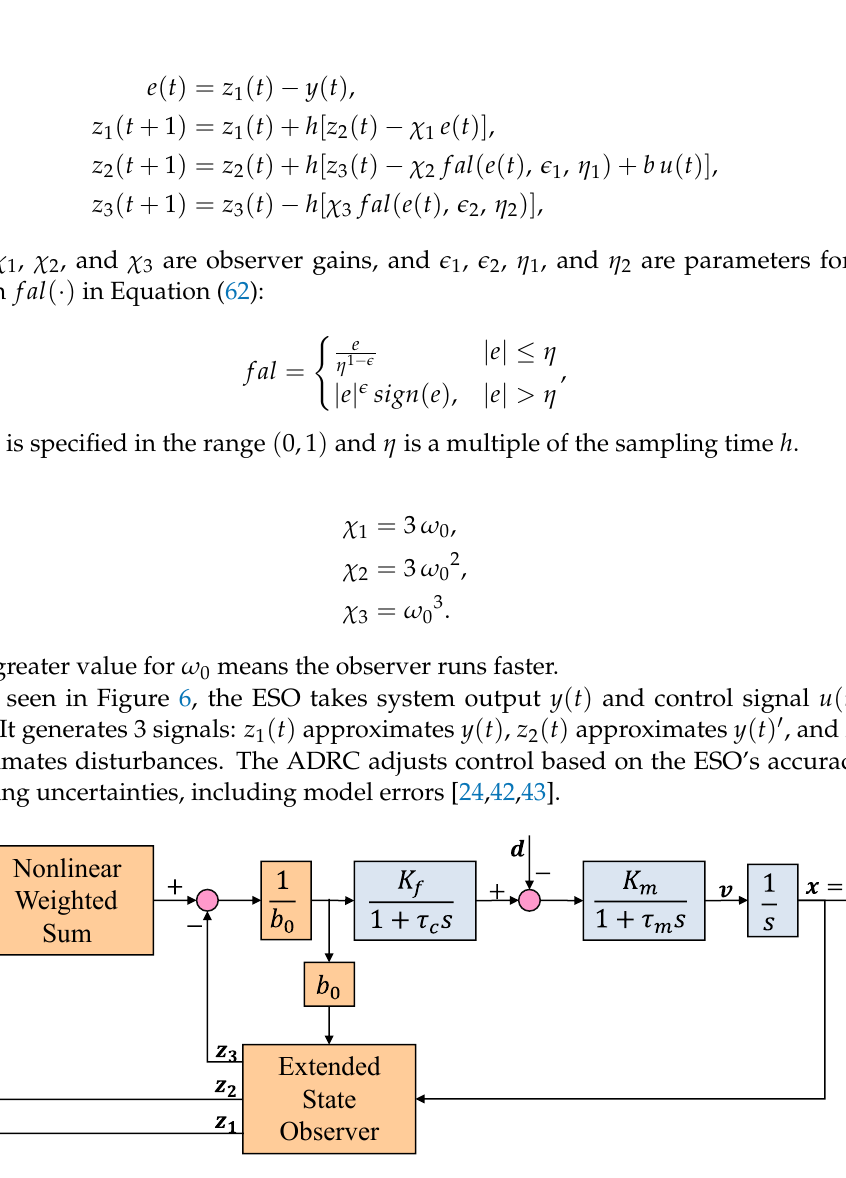
Figure 6. Block diagram of active disturbance rejection